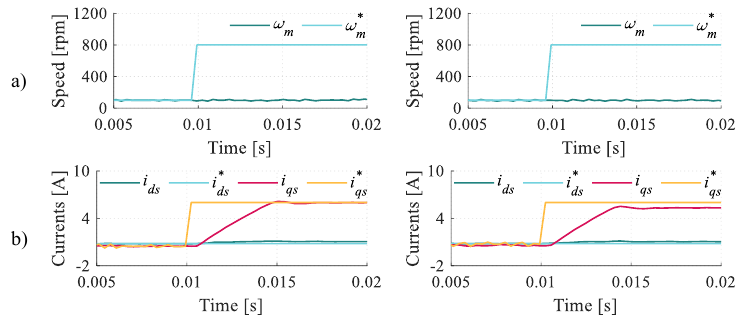
Figure X. Speed-step response of IRFOC CB-PWM (left) and IRFOC CB-PWM without Figure 9. Test 2. Speed-step response of IRFOC CB-PWM ( left ) and IRFOC CB-PWM without integral integral term in 𝑞 -current PI controller. From top to bottom: a) Mechanical speed, and b) 𝑑 - 𝑞 currents. term ( right ). From top to bottom: ( a ) Mechanical speed and ( b ) d − q currents.